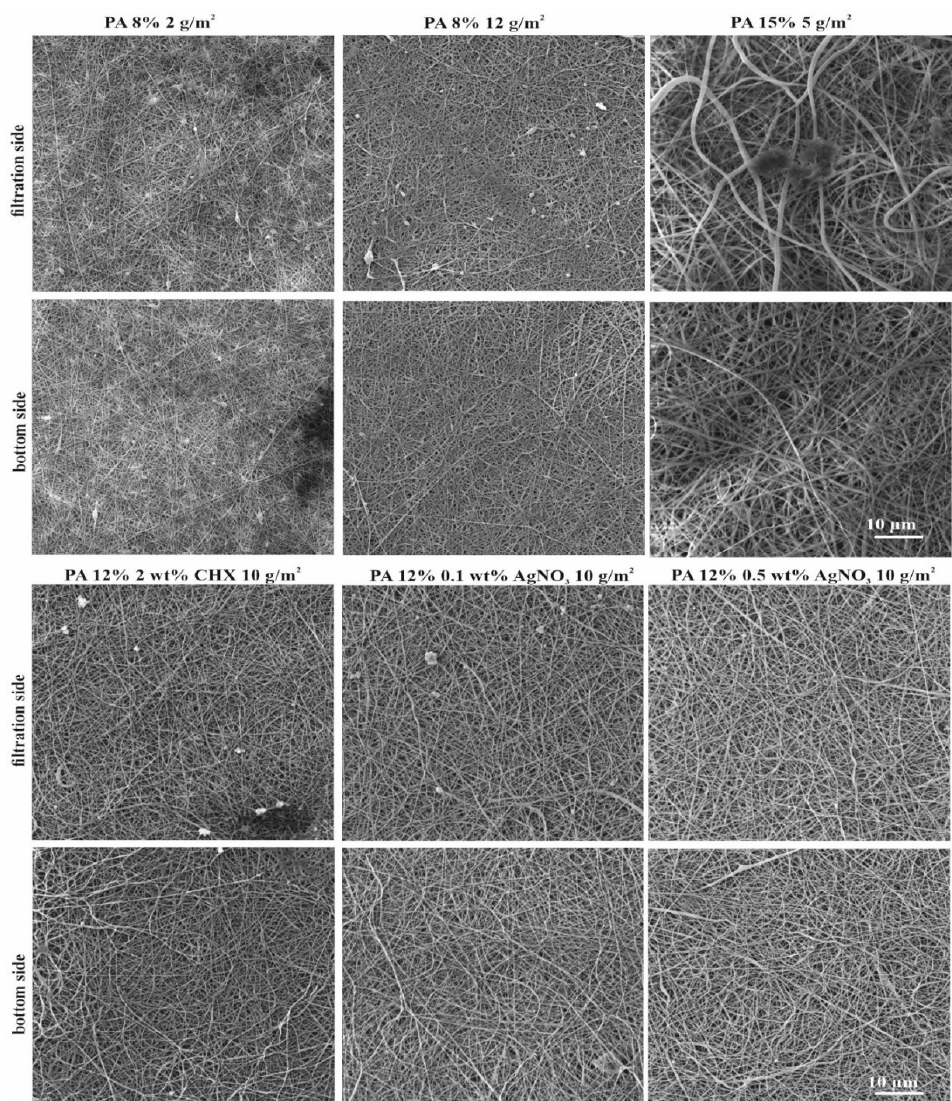
Figure 5. SEM figures of PAs after the filtration of S. aureus CCM 4516 (magnification of 5000×).